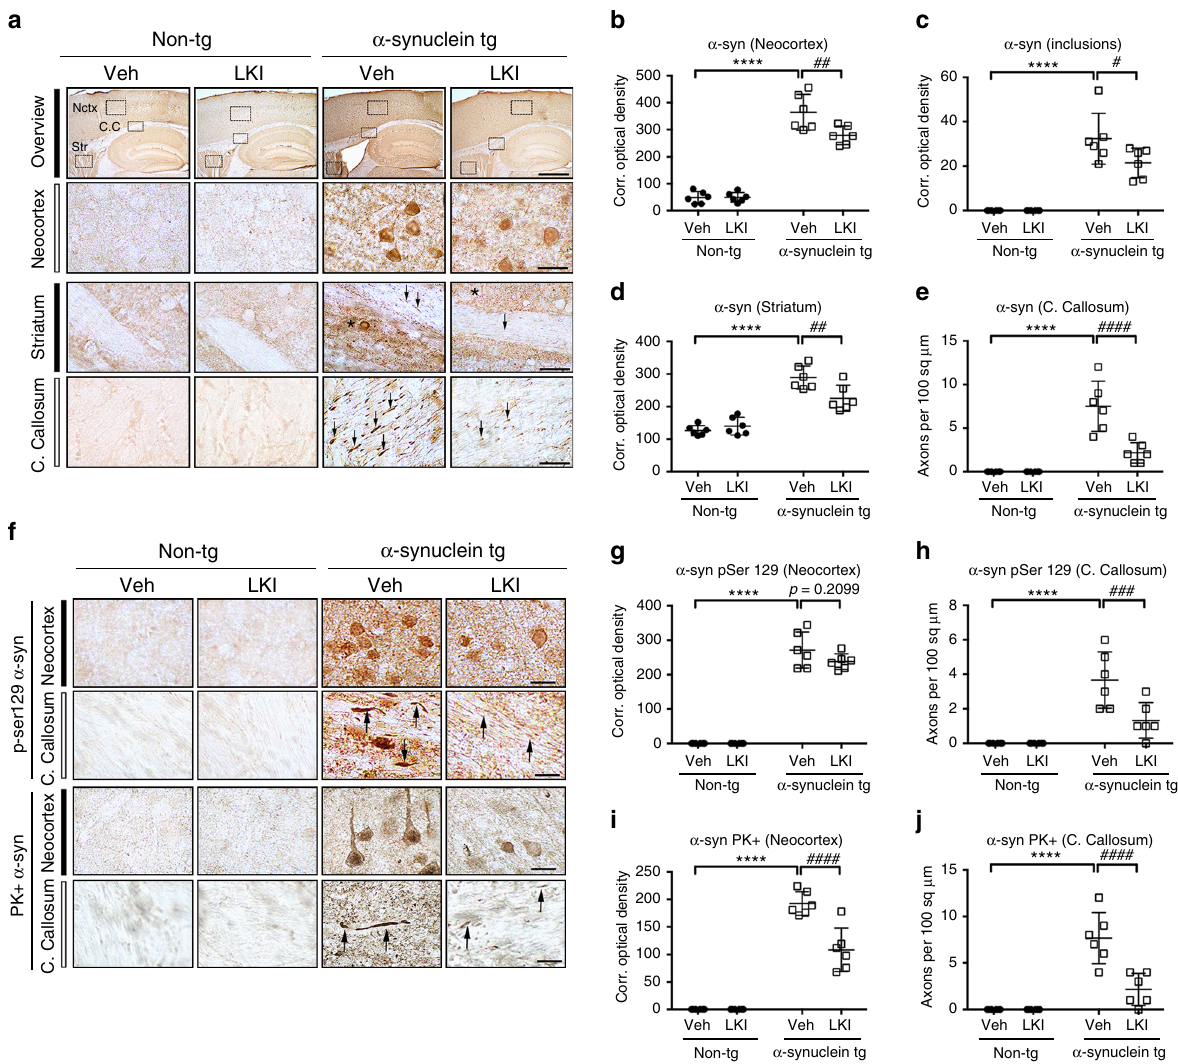
Fig. 8 Blockade of LRRK2 kinase inhibits α – synuclein propagation in mice. a Representative immunohistochemical analysis of α -synuclein in the neocortex (Nctx), striatum (Str), and corpus callosum (C.C) of non-transgenic (non-tg) and α -syn tg mice. Age-matched mice were injected with either vehicle (Veh) or LRRK2 inhibitor (LKI) for 4 weeks. Scale bars, 250 μ m (low magni fi cation) and 25 μ m (high magni fi cation). b – e Optical analysis of α -synuclein deposition in non-tg and α -syn tg mice ( b ) Optical density analysis of α -synuclein immunoreactivity in neocortex. Treatment F(1,20) = 6.601, Genotype F (1,20) = 276.8, Interaction F(1,20) = 6.919, **** p < 0.001, ## p < 0.01. c The number of α -synuclein inclusion positive cells in neocortex. Treatment F(1,20) = 4.034, Genotype F(1,20) = 99.61, Interaction F(1,20) = 4.034, **** p < 0.001, # p < 0.05. d Optical density analysis of α -synuclein immunoreactivity in striatum. Treatment F(1,20) = 3.88, Genotype F(1,20) = 96.22, Interaction F(1,20) = 9.303, **** p < 0.001, ## p < 0.01. e The number of α -synuclein-positive axons in corpus callosum. Treatment F(1,20) = 17.66, Genotype F(1,20) = 58, Interaction F(1,20) = 17.66, **** p < 0.001, #### p < 0.001. f Representative immunohistochemical analysis of phosphorylated (pSer129)- and Proteinase K (PK)-resistant α -synuclein in the neocortex and corpus callosum of non-tg and α -syn tg mice. Brain sections were immunostained against either phosphorylated- α -synuclein (pSer129) or α -synuclein following PK treatment. Scale bars, 250 μ m (low magni fi cation) and 25 μ m (high magni fi cation). g Optical density analysis of phosphorylated α -synuclein immunoreactivity in neocortex. Treatment F(1,20) = 2.064, Genotype F(1,20) = 476.2, Interaction F(1,20) = 2.064, **** p < 0.001. h The number of phosphorylated α -synuclein-positive axons in corpus callosum. Treatment F(1,20) = 8.75, Genotype F(1,20) = 40.18, Interaction F(1,20) = 8.75, **** p < 0.001, ### p < 0.005. i Optical density analysis of PK-resistant α -synuclein immunoreactivity in neocortex. Treatment F(1,20) = 20.97, Genotype F(1,20) = 269.3, Interaction F(1,20) = 20.97, **** p < 0.001, #### p < 0.001. j The number of PK-resistant α -synuclein-positive axons in corpus callosum. Treatment F(1,20) = 17.4, Genotype F(1,20) = 55.61, Interaction F(1,20) = 17.4, **** p < 0.001, #### p < 0.001. All analyses were done with N = 6 mice per group. All data were analyzed by using